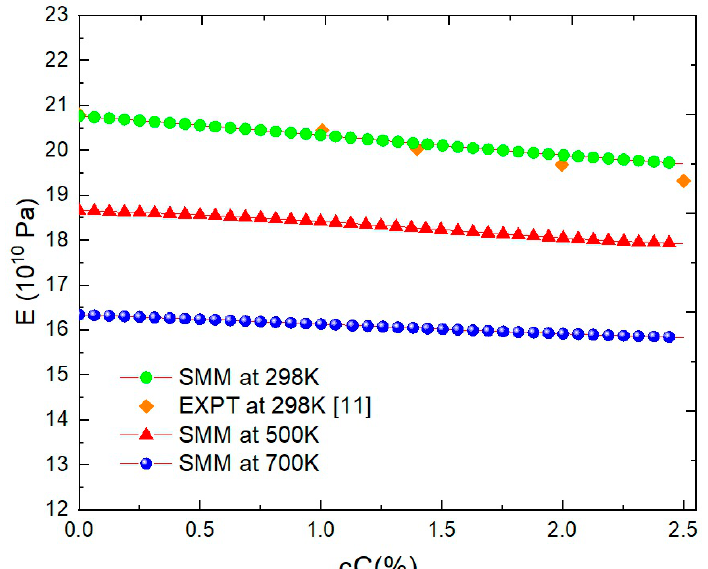
Figure 2. E(cC) for FeC at P = 0, T = 298 K, 500 K, 700 K obtained using the SMM and at P = 0, T = 298 K from EXPT [11].